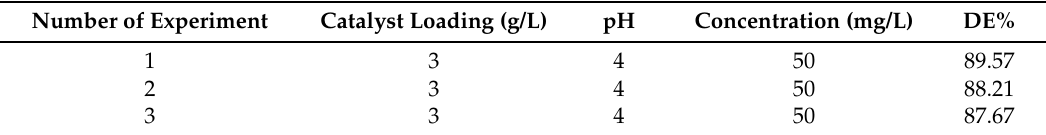
Table 8. Results of experimental runs for model validation.